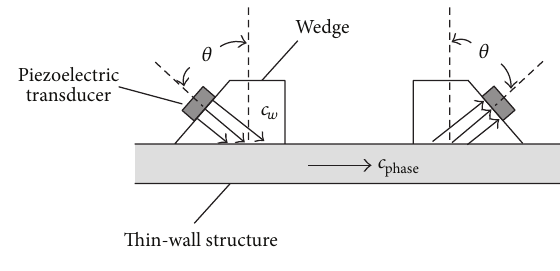
Figure 3: Wave tuning using a wedge.